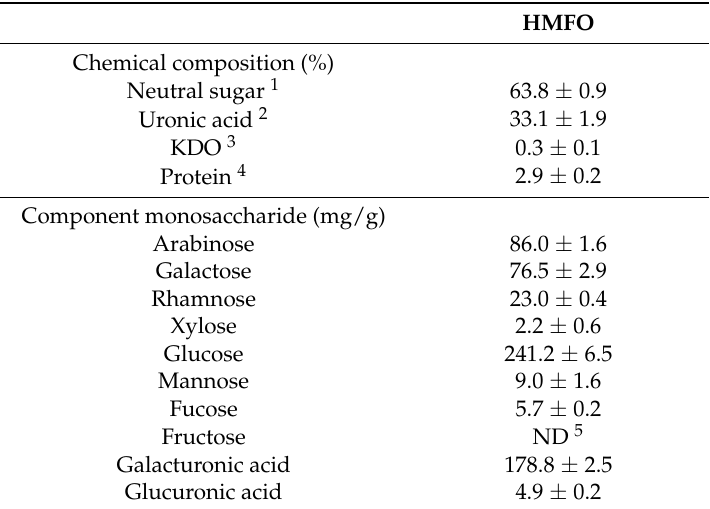
Table 2. The chemical and monosaccharide composition of